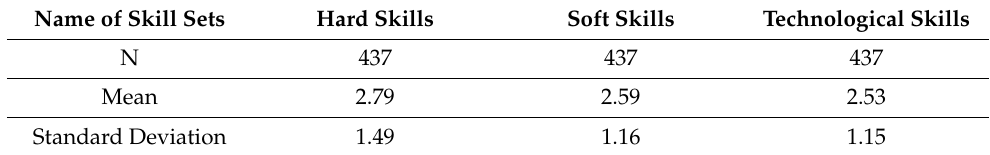
Table 4. Mean score of frequency of evaluation of current skills set for future